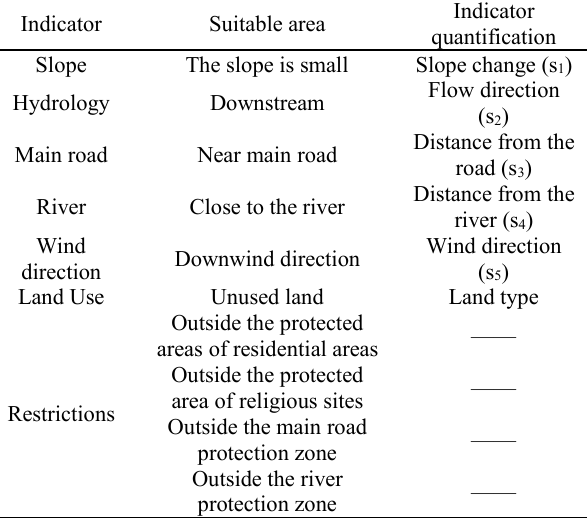
Table 1. Suitability